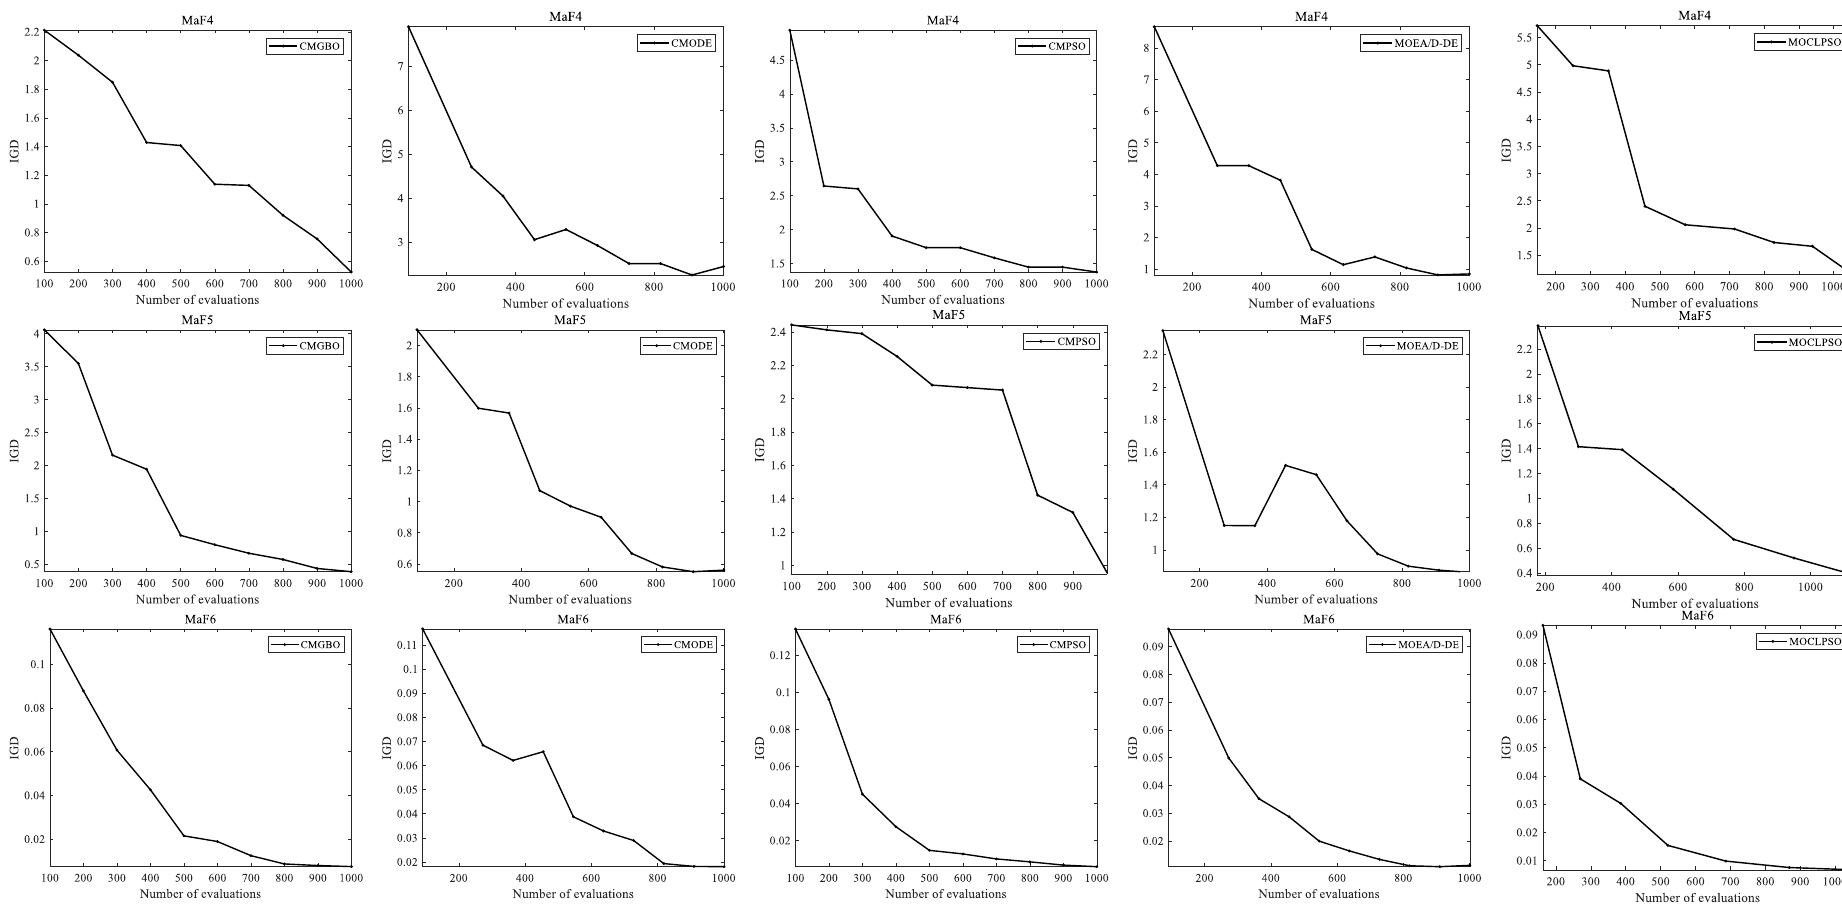
Figure 9. IGD metric characteristics of MaFs obtained by each algorithm.